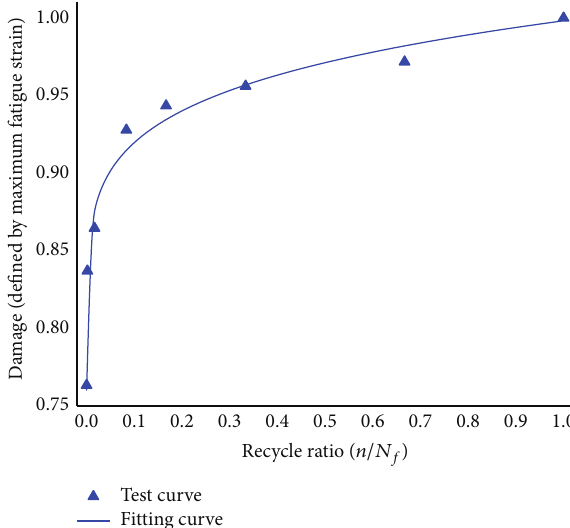
Figure 10: Damage result of JL-3 based on fatigue residual